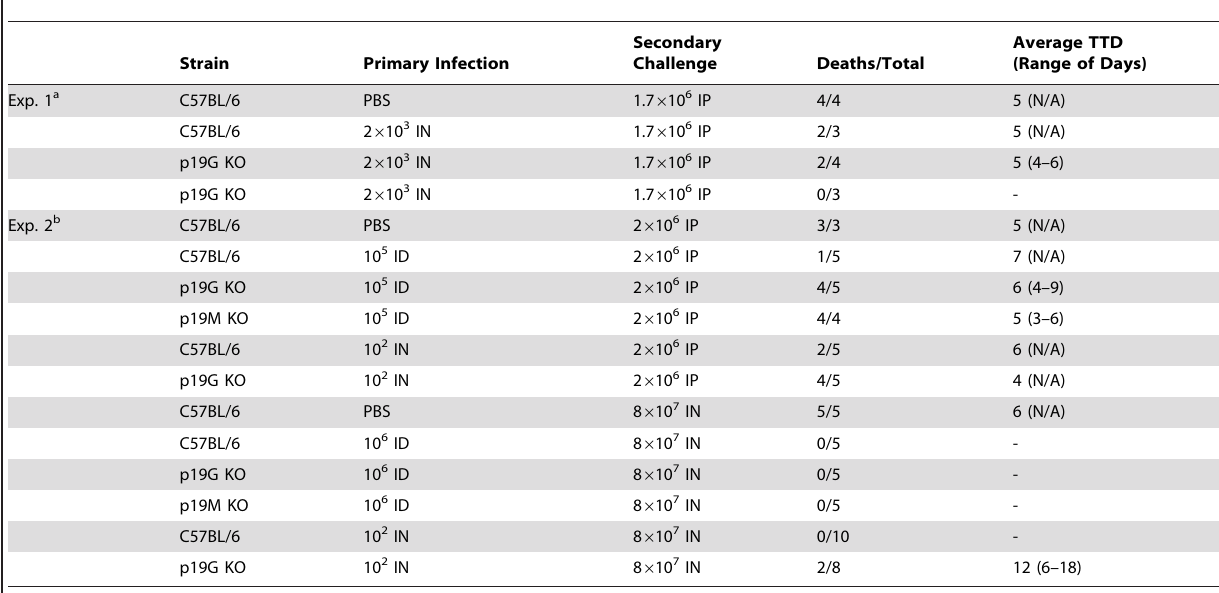
Table 2. Similar survival of lethal challenge by LVS-vaccinated WT and IL-23 KO mice.